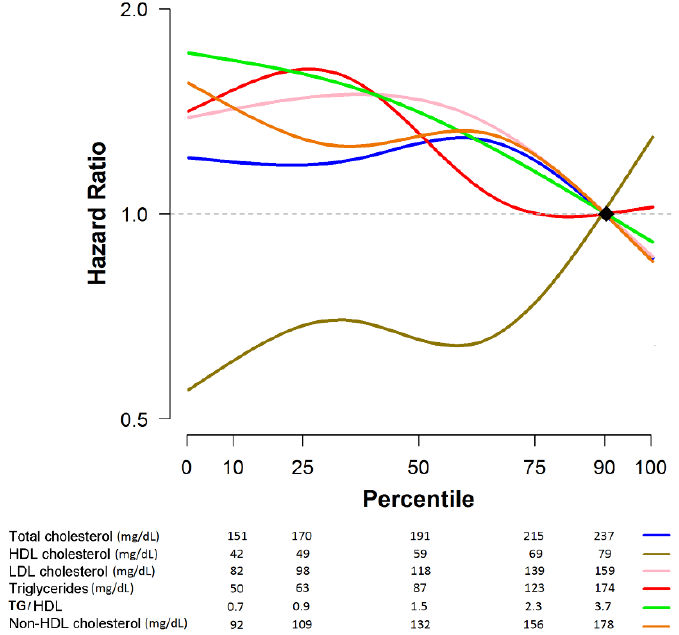
Figure 3. Hazard ratio by lipid exam score. HDL: high density lipoprotein; LDL: low density lipoprotein; TG: total cholesterol.